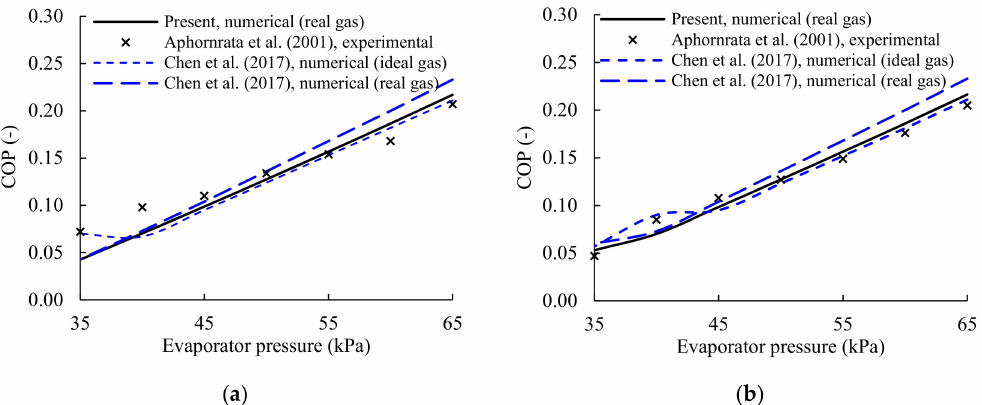
Figure 6. Comparison of predicted ejector refrigeration system COP in critical mode operation as a function of the evaporator pressure, with the corresponding experimental data of Aphornratana et al. [33], and numerical data of Chen et al. [20], at a generation (i.e., primary flow inlet) temperature of 110 ◦ C and condenser pressure of either ( a ) 160 kPa or ( b ) 170